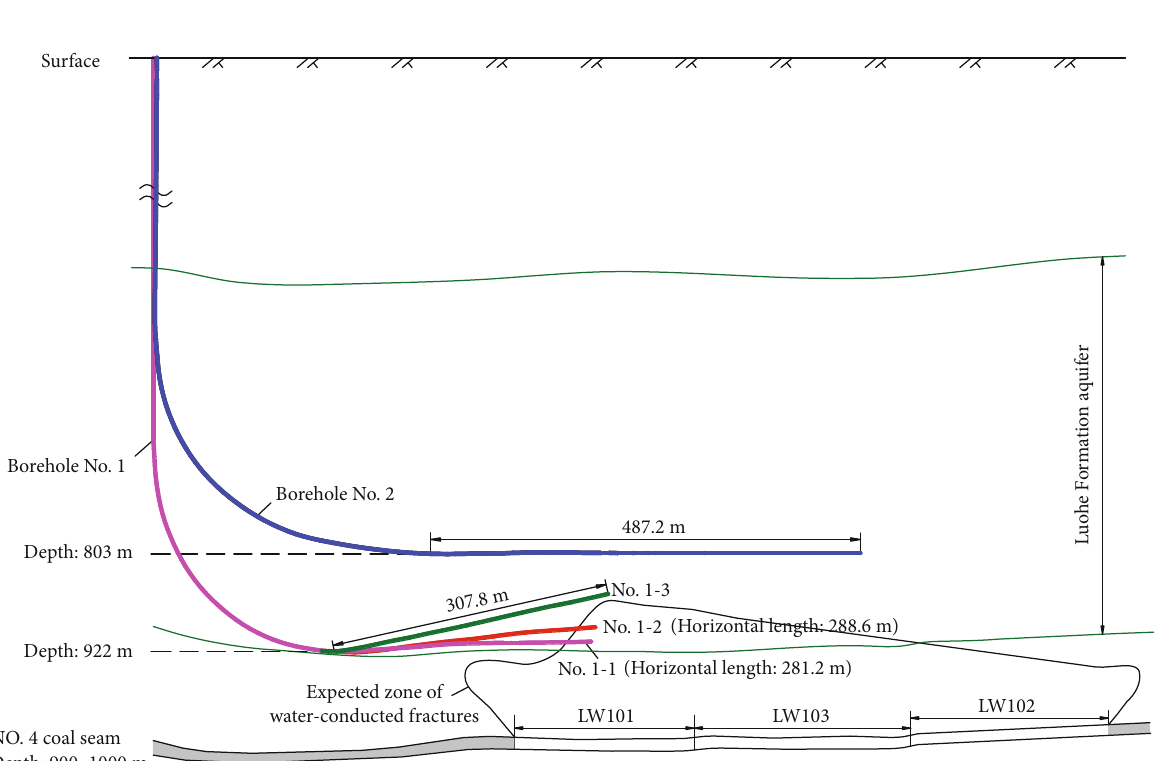
Figure 2: Trajectory of the HDD borehole in the Gaojiabao coal